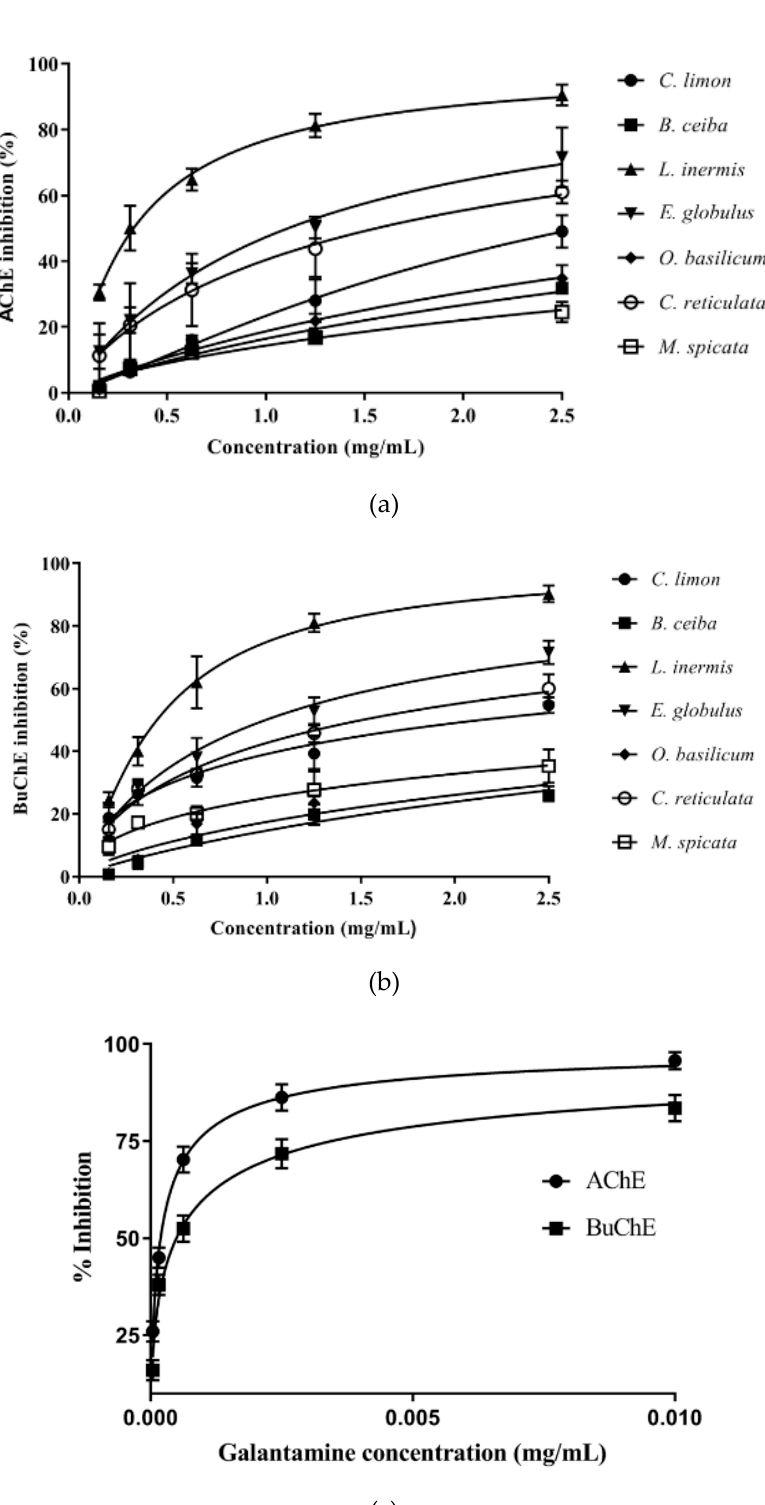
Figure 2. Assessment of the ability of plant extracts and galantamine to inhibit AChE and BuChE. ( a ) Inhibition of AChE by plant extracts. ( b ) Inhibition of BuChE by plant extracts. ( c ) Inhibition of AChE and BuChE by galantamine. Assays were performed using modified Ellman’s assay [40]. Results are expressed as means ± SEM, for an n -number of 4.